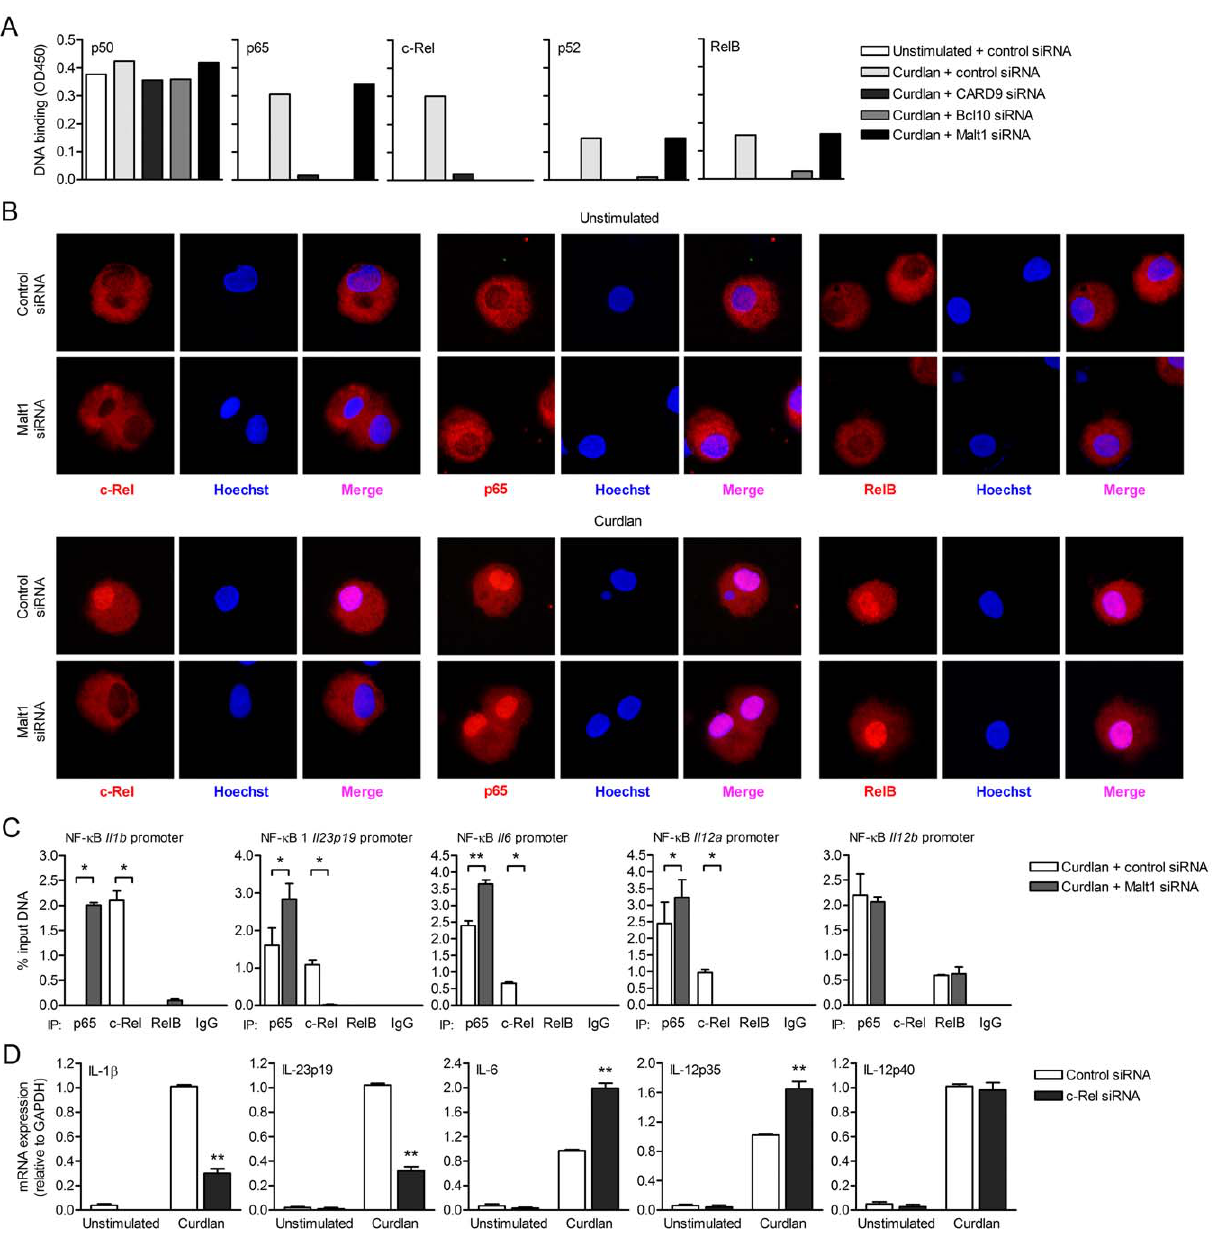
Figure 2. Malt1 signaling by dectin-1 is specifically required for c-Rel-dependent cytokine expression. (A) DNA binding of NF- k B subunits in nuclear extracts of curdlan-stimulated DCs after Malt1 silencing by RNA interference (siRNA). Graphs are representative of three independent experiments. (B) Translocation of c-Rel, p65 or RelB (red) into the nucleus (Hoechst staining, blue; colocalization (Merge, pink)) in curdlan-stimulated DCs after Malt1 silencing. Stainings are representative of two independent experiments. (C) ChIP assays were performed to determine binding of p65, c-Rel and RelB to NF- k B binding motifs of the Il1b , Il23p19 , Il12a , Il12b and Il6 promoters. Protein-DNA complexes were immunoprecipitated from sheared chromatin isolated from para -formaldehyde-fixed curdlan-stimulated DCs after Malt1 silencing by RNA interference (siRNA). Immunoprecipitation with mouse IgG served as a negative control. Quantitative real-time PCR reactions for indicated regions were performed. Levels are normalized with respect to the ‘input DNA’ sample, which had not undergone immunoprecipitation; results are expressed as the % input DNA. Data are mean 6 s.d. of two independent experiments, * p , 0.05 and ** p , 0.01 (Student’s t -test). (D) Quantitative real-time PCR for indicated mRNAs in curdlan-stimulated DCs after c-Rel silencing by RNA interference (siRNA). Expression is normalized to GAPDH and set at 1 in curdlan-stimulated cells. Data are mean 6 s.d. of four independent experiments, ** p , 0.01 (Student’s t -test). doi:10.1371/journal.ppat.1001259.g002 patients [24,26]. C. lusitaniae CBS4413 induced cytokine produc- was largely dependent on Malt1 protease activity ( Figure 4B ). tion in a dectin-1-dependent manner, while C. nivariensis CBS9983 was only partially dependent on dectin-1 signaling for the production of IL-1 b , IL-23, IL-6 and IL-12p70 ( Figure 4B ). Both IL-1 b and IL-23 production by C. lusitaniae and C. nivariensis